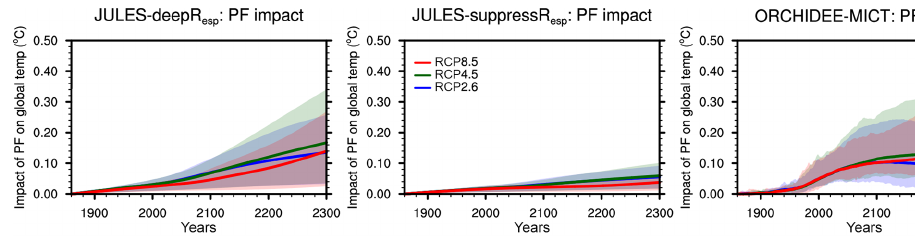
Figure 7. The impact of the permafrost carbon release on the change in global air temperature (PF minus non-PF).